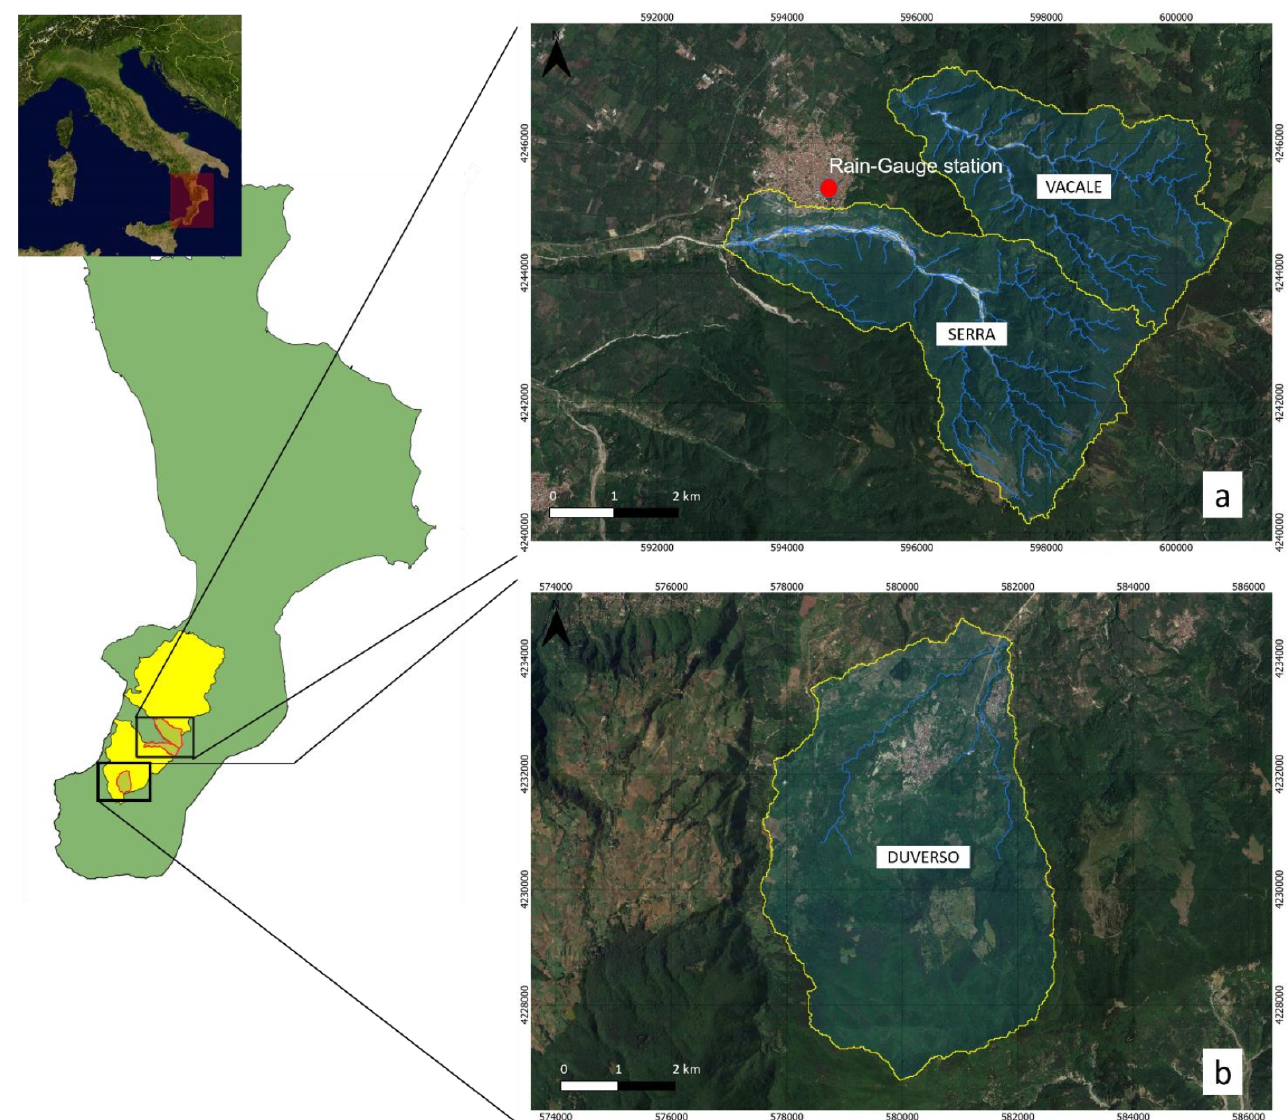
Figure 1. Location of the study area with Vacale and Serra ( a ) as well as Duverso ( b ) torrents (Calabria, Southern